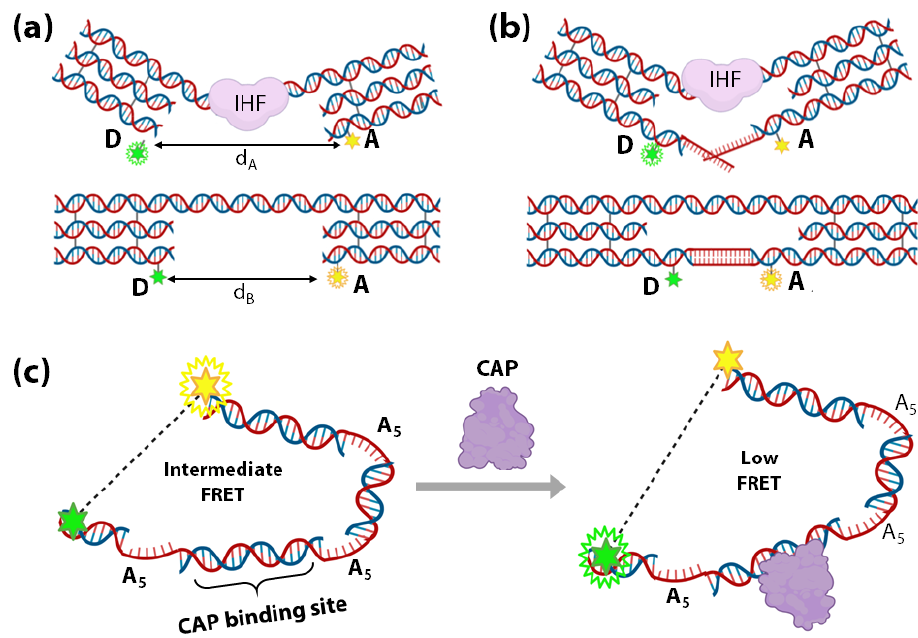
Figure 7. ( a , b ) Schematic representation of a nanomechanical device with the double helices as rectangular boxes and the TX motifs as three infused rectangular boxes. The upper domain connects the two TX motifs with the binding site for IHF. Each TX motif is labelled with either FRET donor fluorescein (D) or FRET acceptor Cy3 (A). IHF (purple) binding distorts the connecting shaft in the lower panel, consequently increasing the distance between D and A (d B to d A ) and thus decreasing FRET. ( b ) shows that the bottom domains are extended and connected by a cohesive tract [189]. DNA bending-based TF (CAP) sensor. ( c ) Left: Schematic of the sensor constituted by a dsDNA consisting of three A 5 kinks and a CAP binding site (indicated by the blue dotted line). The donor (glowing green star) and the acceptor (glowing yellow star) fluorophores are depicted to be attached on either end of the sensor dsDNA, respectively. Right: Schematic of the pulling far apart of both the fluorophore-tagged ends of the dsDNA sensor from each other due to DNA bending induced by CAP binding [191].